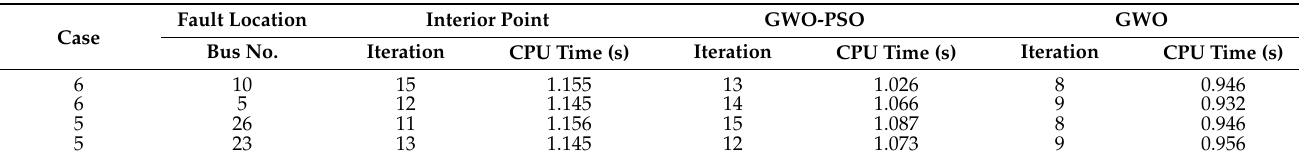
Table 8. Comparing computational time and iterations taken by an optimization algorithm for the adaptive part of the hybrid protection scheme.